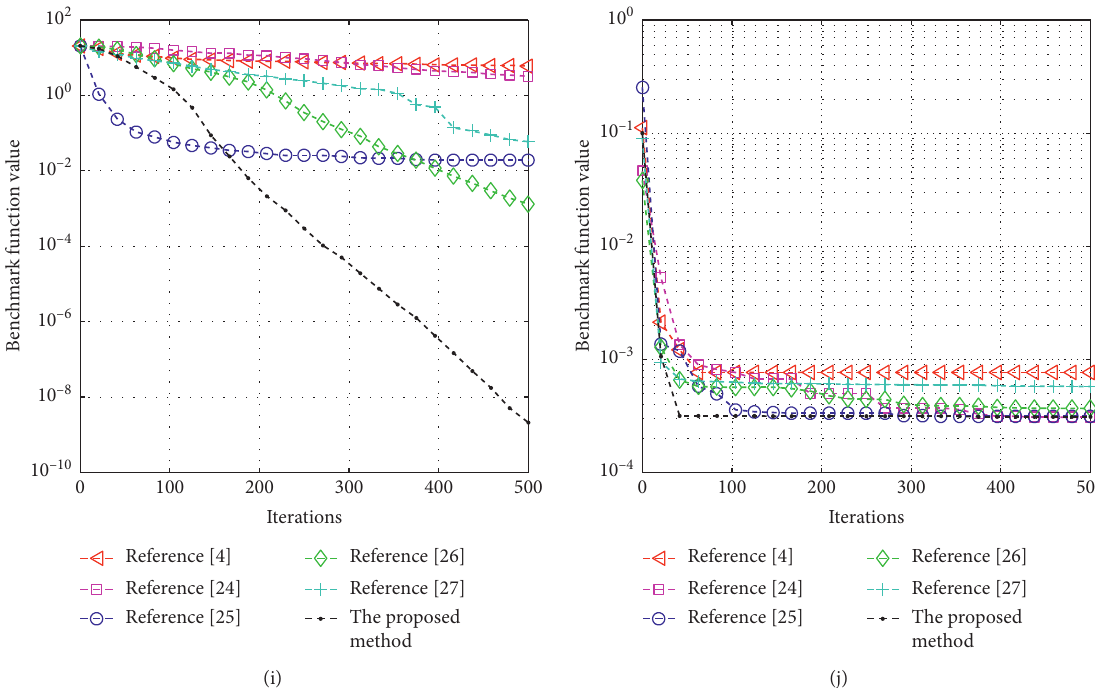
: Alpine ( d � 50 ) , (d) 5 : Ackley ( d � 30 ) , (i) 7